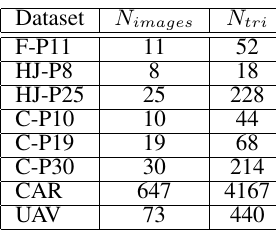
Table 2. Number of images ( N images ) and triplets ( N tri ) in re- spective datasets.